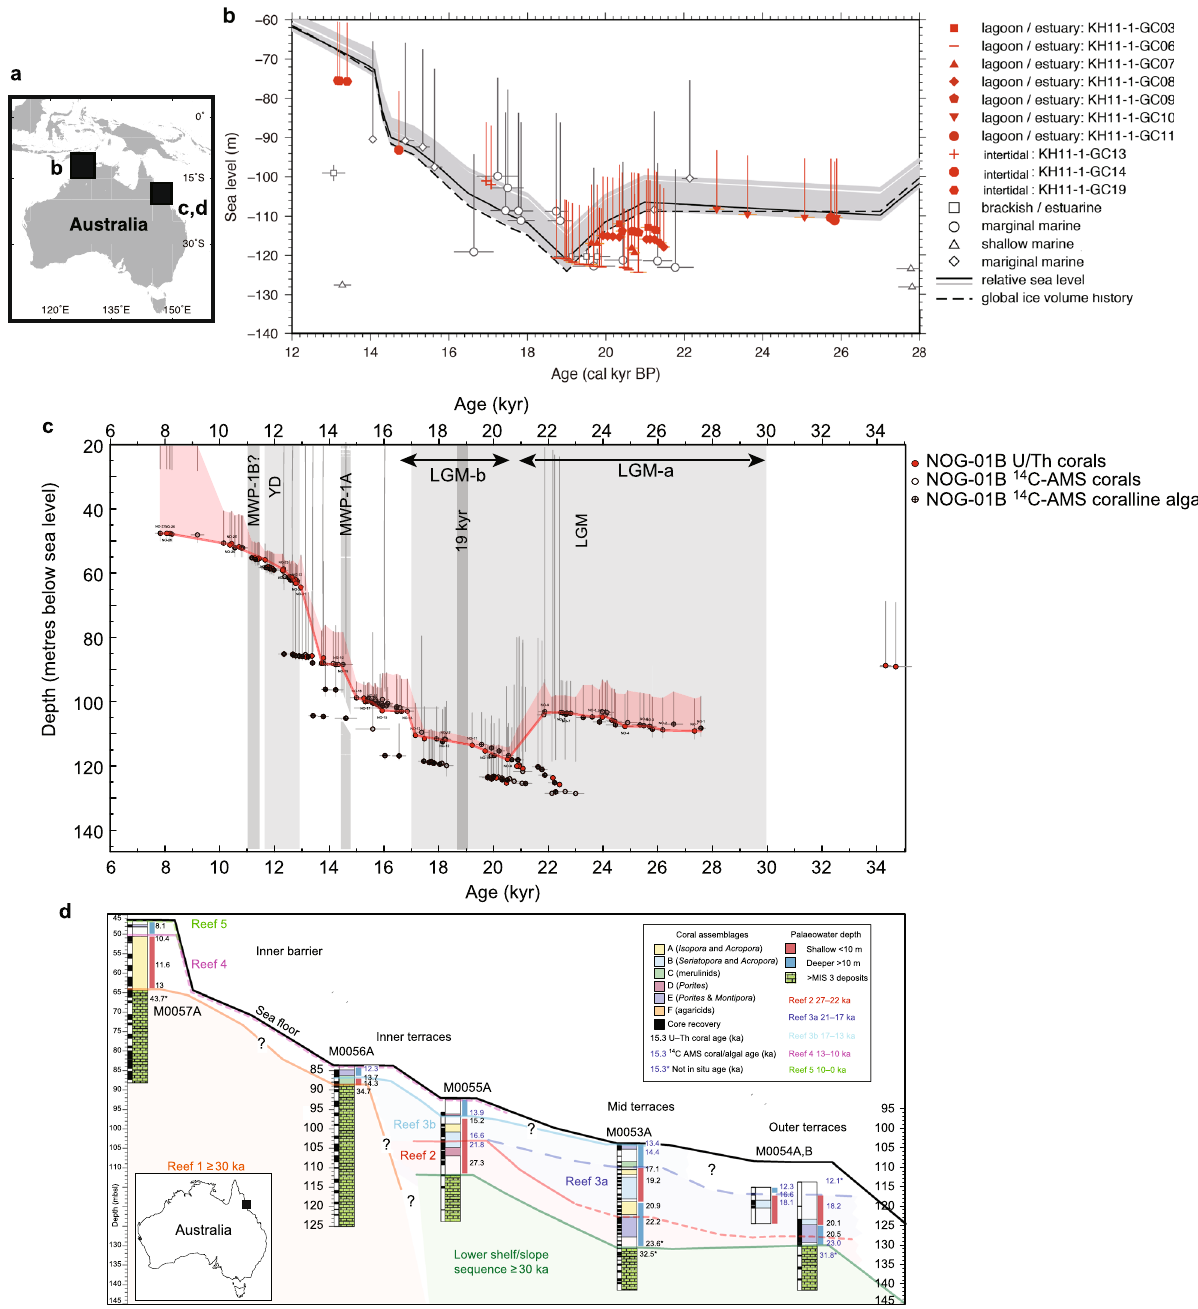
Fig. 1 | Tightly constrained Last Glacial Maximum (LGM) sea level record from around the Australian coast. a Map showing locations of relative sea level (RSL) reconstructions using series of cores obtained from northwestern (Bonaparte Gulf 3,4 ) and northeastern Australia (the Great Barrier Reef: GBR 5 ). b The Bonaparte Gulf cores were retrieved from different water depths designed to capture the full rangeofLGMRSL.Detailsoffaciesanalyseswereconductedusingmicrofossilsand radiocarbon dates that con fi rmed local RSL to be as low as − 120 to − 123m during